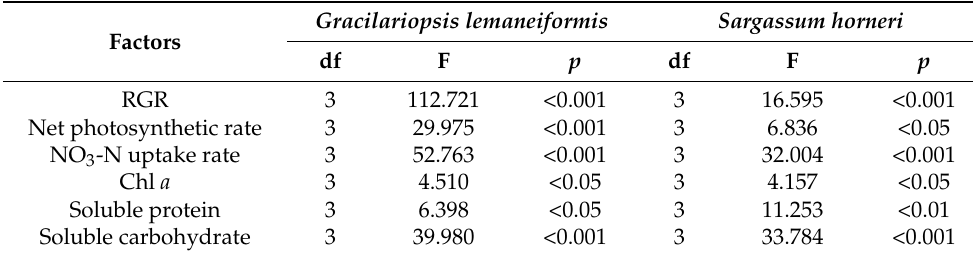
Table 1. One-way ANOVA testing of the effects of biomass density ratio on RGR, net photosynthetic rate, NO 3 -N uptake rate, Chl a , soluble protein, and carbohydrate of Gracilariopsis lemaneiformis and Sargassum horneri